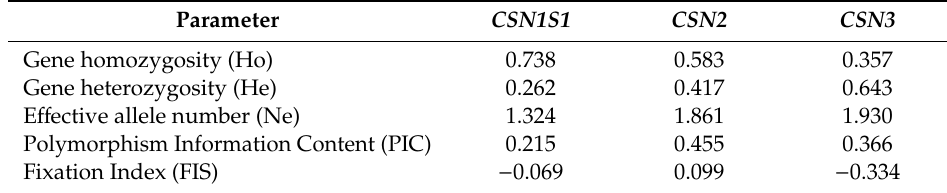
Table 2. Population genetic indices for the three considered loci in the sample of Agerolese cows.